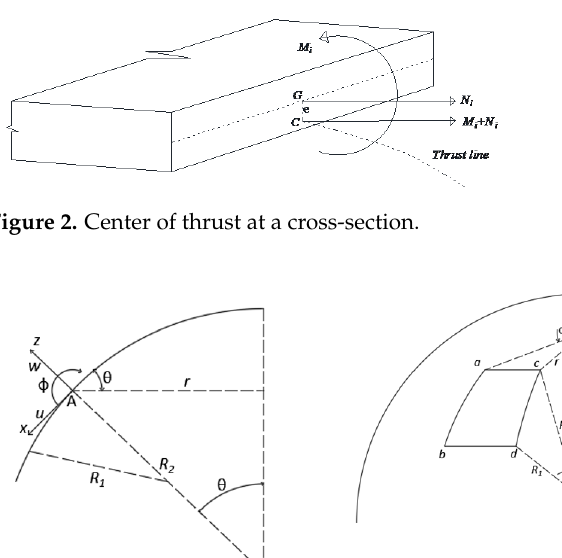
Figure 1. Stress resultants on the dome infinitesimal element.